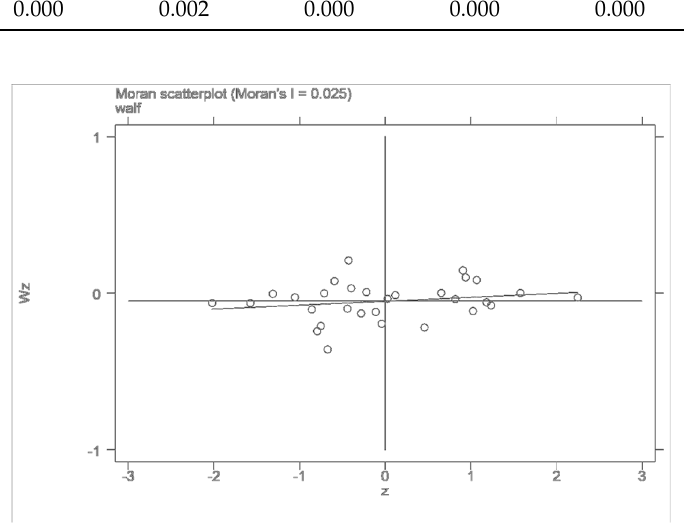
Figure 2. Local Moran scatter plot of residents’ well-being in 2005.